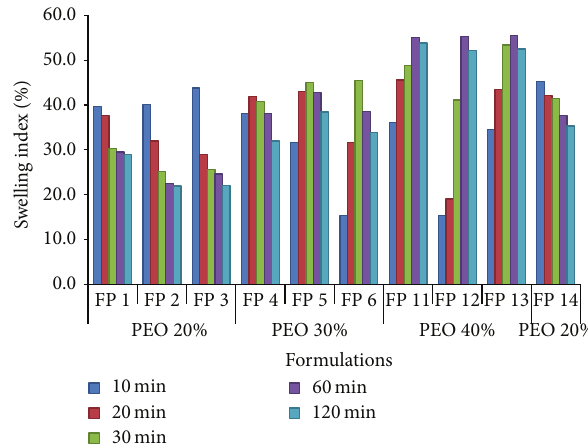
Figure 2: Swelling indices of floating pulsatile release formulations at different time